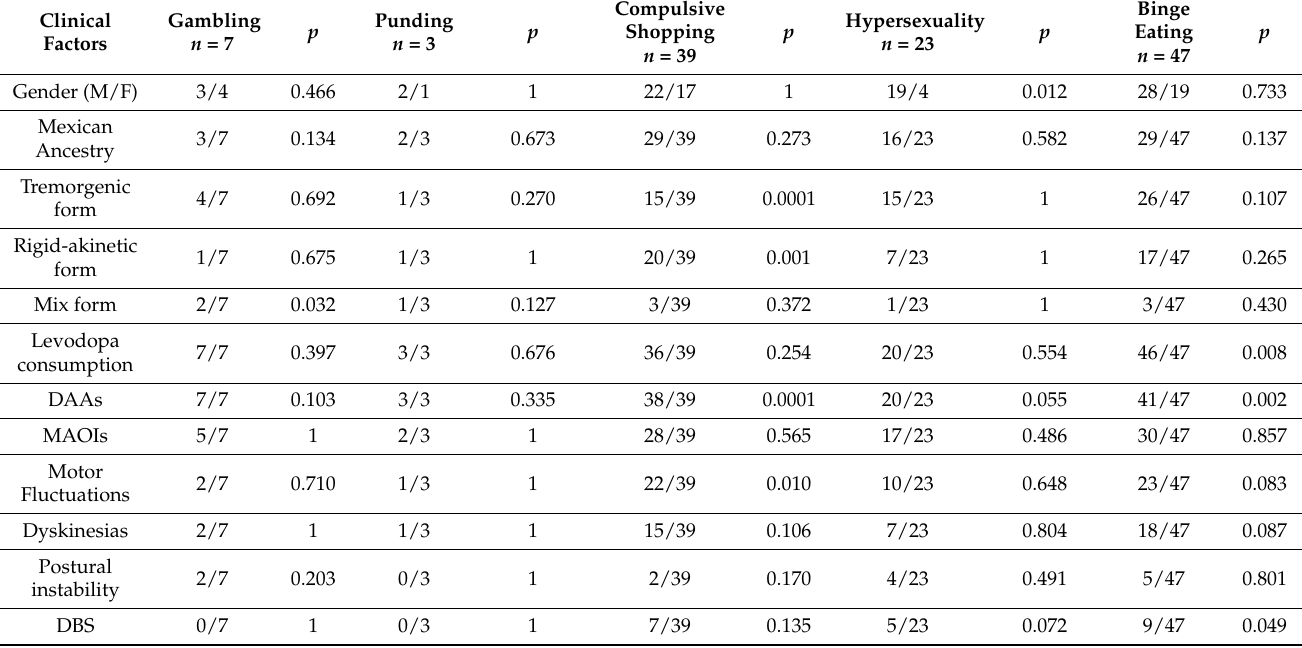
Table 3. Clinical factors, and their association with a spectrum of ICDs.